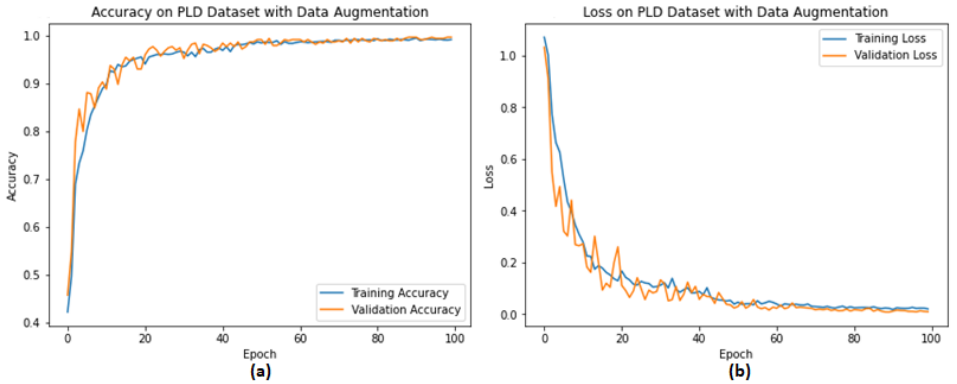
Figure 7. ( a ) Accuracy graph of PDDCNN on PLD using data augmentation. ( b ) Loss graph of PDDCNN on PLD using data